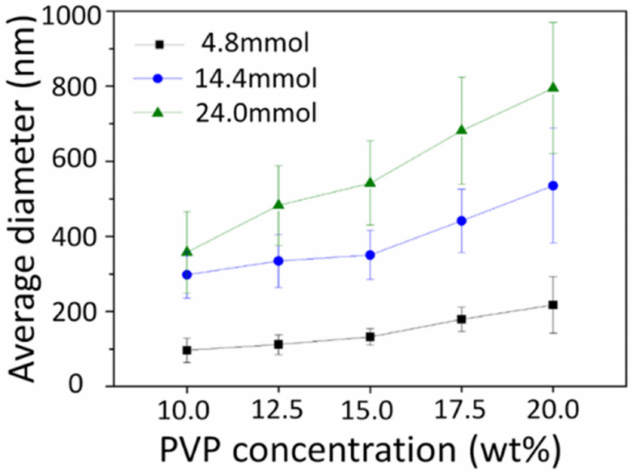
Figure 4. Average diameters of as-spun nanofibers obtained from each precursor